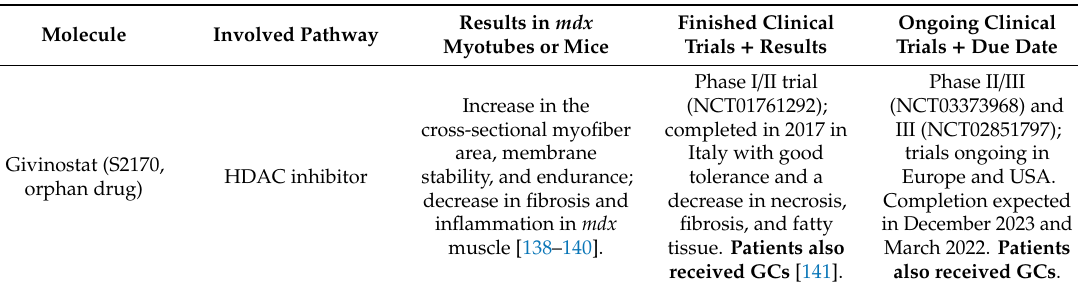
Figure 2. Genomic and non-genomic e ff ects of the glucocorticoid receptor (GR) binding to activated cellular enzymes and the nuclear receptors involved in the Duchenne muscular dystrophy (DMD) myocyte. The GR is depicted in red. Abbreviations: FKBP51 and -52 = immunophilin FK506-binding protein 51 and 52, GCs = glucocorticoids, HDAC3 and -6 = Histone deacetylase 3 and -6, hsp90 = heat shock protein 90, Hop = Hsp70–Hsp90 organizing protein, MR = Mineralocorticoid receptor, SMAD6 = Mothers Against Decapentaplegic homolog 6. Table 7. Overview of histone deacetylase (HDAC) stabilizing molecules: results in mdx myotubes (in vitro) or mice (in vivo), finished clinical trials and results, ongoing clinical trials and due dates, and putative